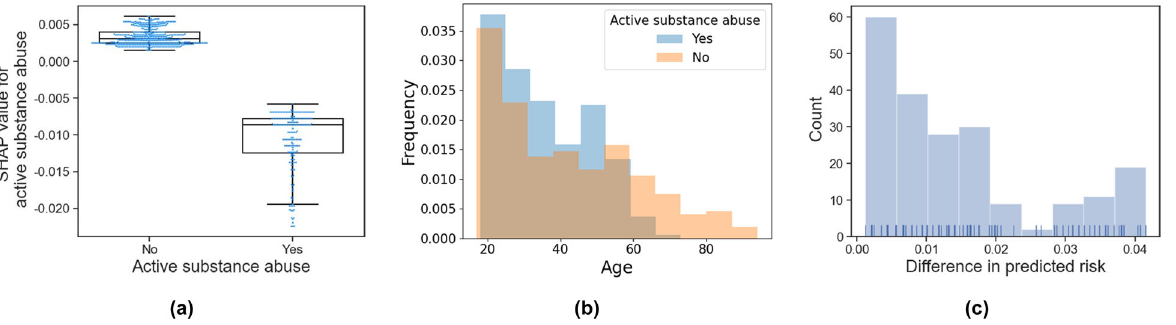
Fig. 2 An example of a variable with counterintuitive behavior. a Shows that active substance abuse yields a negative contribution. Center line and box limits correspond to median and upper and lower quartiles, respectively. b Shows the difference in age distribution between active substance abusers and others. c Shows difference in the predicted risk scores of the test population if the active substance abuse value is set zero or